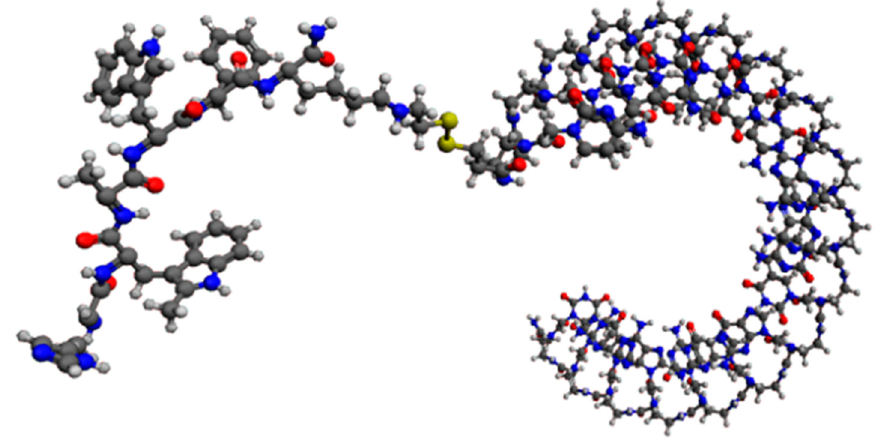
Figure 9. Graphic representation of an 18 mer miR-22-3p antagomir with a PNA backbone coupled with the hexapeptide hexarelin (5 (cid:48) -Hex-S-S-PnaC-PnaT-PnaT-PnaC-PnaT-PnaT-PnaC-PnaA-PnaA- PnaC-PnaT-PnaG-PnaG-PnaC-PnaA-PnaG-PnaC-PnaT-3 (cid:48)